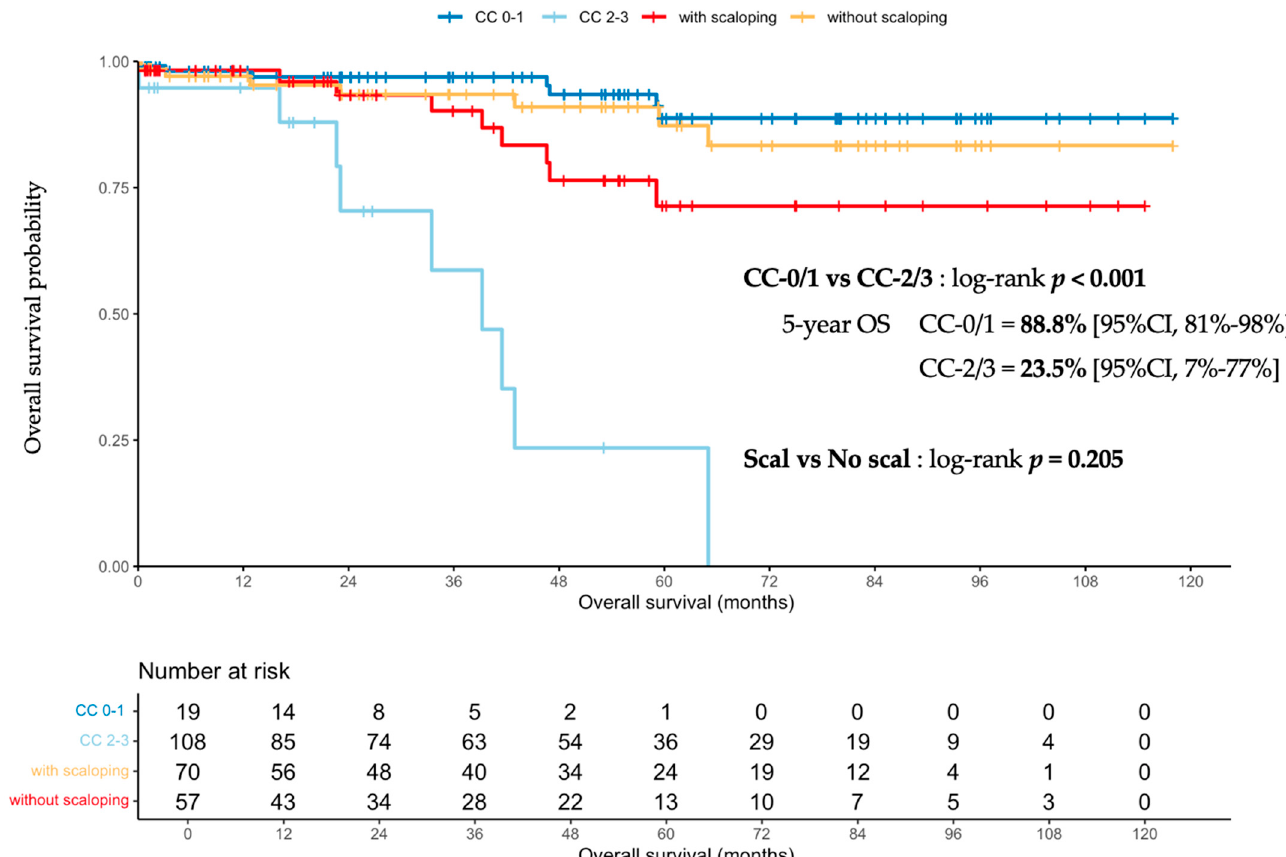
Figure 4. Overall survival probability in the overall population comparing completely to incom- pletely resected patients, and patients with scalloping to those without. CC-0/1, completeness of cytoreduction score of 0 or 1 corresponding to a complete cytoreductive surgery; OS, overall survival; Scal, scalloping.